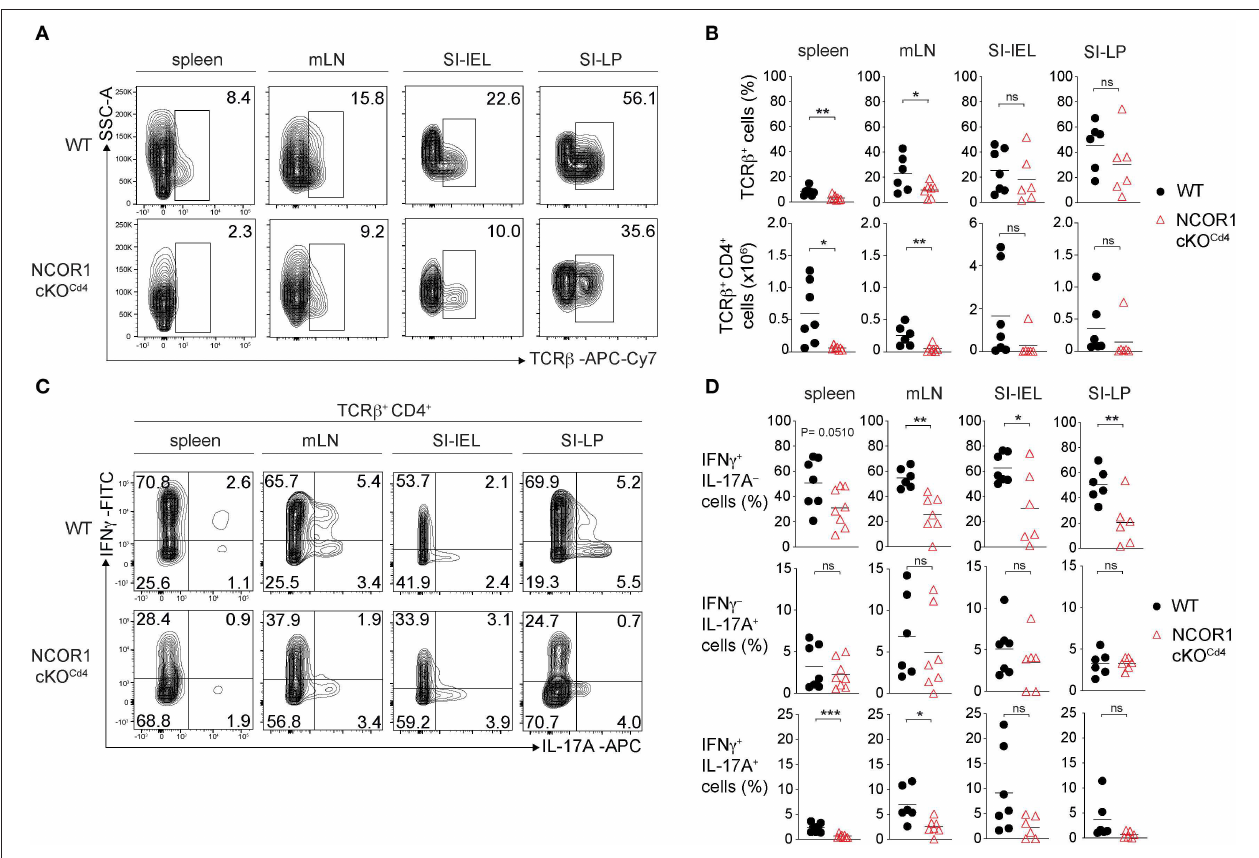
FIGURE 6 | Homeostasis and cytokine expression of NCOR1-deficient CD4 + T cells upon transfer. (A) Naïve WT or NCOR1 cKO Cd4 CD4 + T cells were i.p. injected into Rag2 − / − mice and 8 weeks later transferred CD4 + T cells in recipient mice were analyzed. Contour plots show TCR β expression vs. side scatter (SSC-A) of cells isolated from spleen, mLNs, small intestine IELs (SI-IELs) and lamina propria cells (SI-LPs) of recipient Rag2 − / − mice. (B) Diagrams depict the percentages of TCR β + cells (upper panel) and numbers of TCR β + CD4 + cells (lower panel) in the indicated organs of Rag2 − / − mice that have received either naïve WT or NCOR1 cKO Cd4 CD4 + T cells. (C) Contour plots depict IL-17A vs. IFN γ expression of cells isolated from spleen, mLNs, SI-IELs, and SI-LP cells of recipient Rag2 − / − mice. (D) Diagrams indicating percentages of IFN γ single-producing cells (IFN γ + IL-17A − ) (upper panel), IL-17A single-producing cells (IFN γ − IL-17A + ) (middle panel) and IFN γ + IL-17A + double-producing (lower panel) TCR β + cells isolated from Rag2 − / − mice that have received either naïve WT or NCOR1 cKO Cd4 CD4 + T cells. (A,C) Representative plots for the various organs and tissues were taken from different experiments, however for each organ/tissue shown WT and NCOR1 cKO Cd4 plots are from the same experiment. Numbers indicate the percentage of cells in the respective quadrants or regions. (B,D) Horizontal bars indicate the mean. * P < 0.05, ** P < 0.01, *** P < 0.001, ns, not significant (unpaired two-tailed t -test). Data are representative (A,C) or show summary (B,D) of 6–8 mice that were analyzed in 3 independent